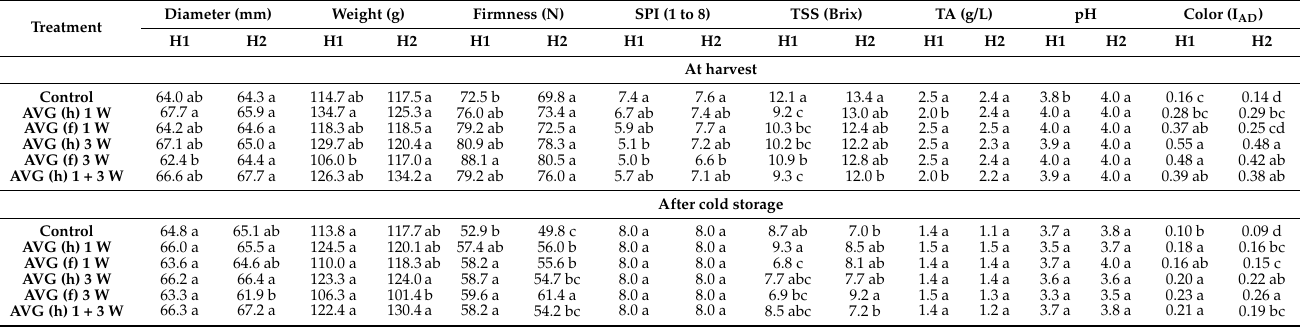
Table 1. Effects of AVG on fruit quality of ‘Brookfield Gala’ apples at harvest and after cold storage, 2018, Exp. 1.